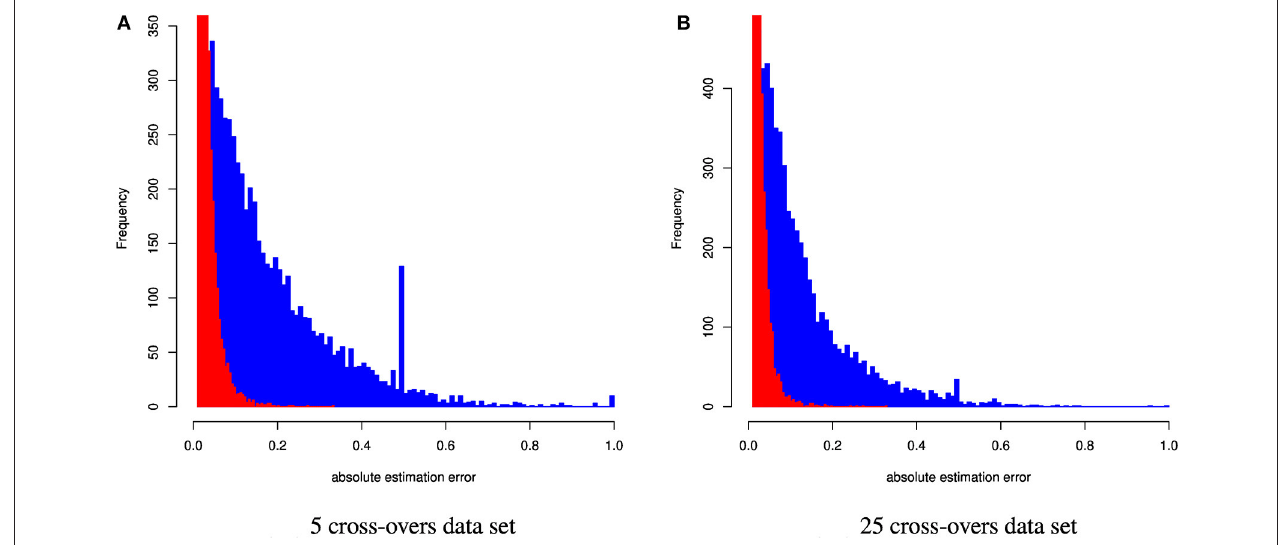
FIGURE 4 | Distribution of the absolute estimation error from CGR (red) and ADMIXTURE (blue) for the human data set generated using 5 and 25 cross-overs and 150k genetic markers.